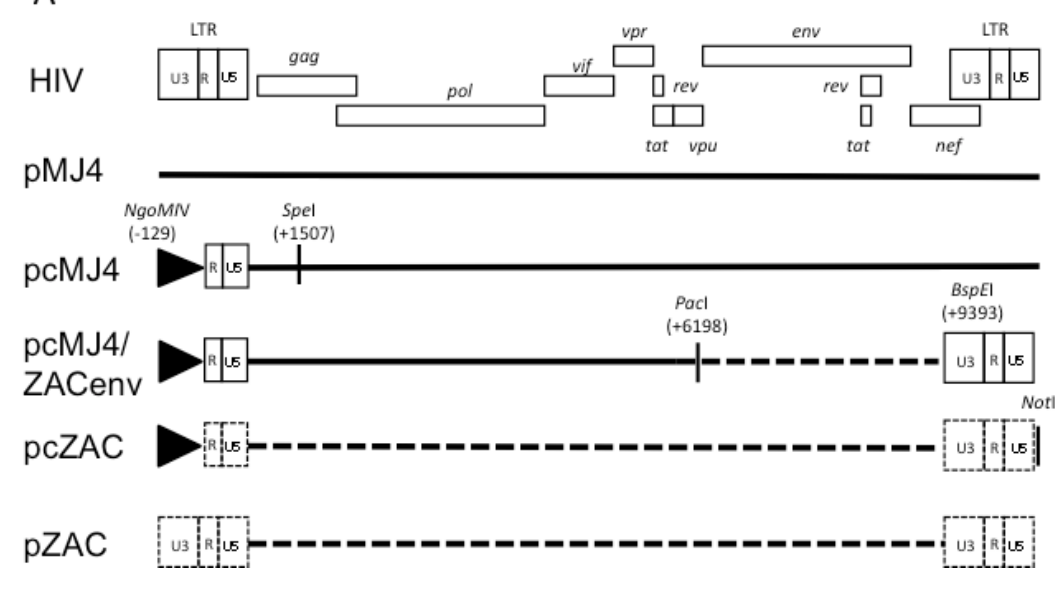
Figure 1. Molecular characterization of pZAC, an infectious proviral clone from Cape Town, South Africa. ( A ) Cloning strategy used during the study. The U3 promoter of pMJ4 was replaced with a CMV-IE promoter, as indicated. The CMV-promoter is represented by a triangle. The proviral clone pcMJ4 was used as a backbone for further characterization of pZAC. Dotted lines indicate patient ZAC derived sequences. The enzyme restriction sites used for cloning are indicated. ( B ) Transient virus titer on TZM-bl of infectious proviral clones. After transfection of HEK 293T cells, cultured supernatants were titrated on HeLa Titers and standard deviation were derived from three independent